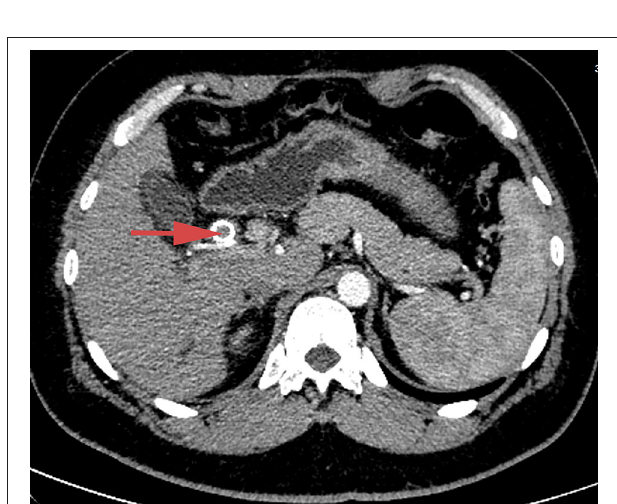
FIGURE 4 | Abdominal contrast-enhanced CT scan, showing high-density shadow in the initially placed biliary metal stent and lumen